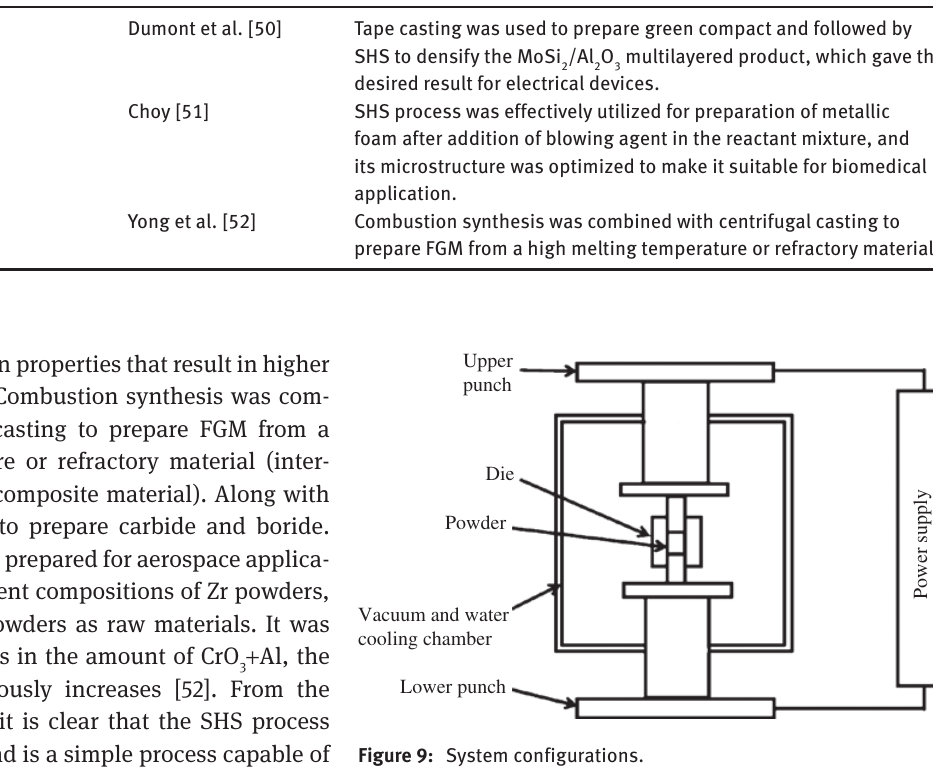
Table 4: List of different authors who used SHS for fabrication of FGM. Sr. no. Material combination